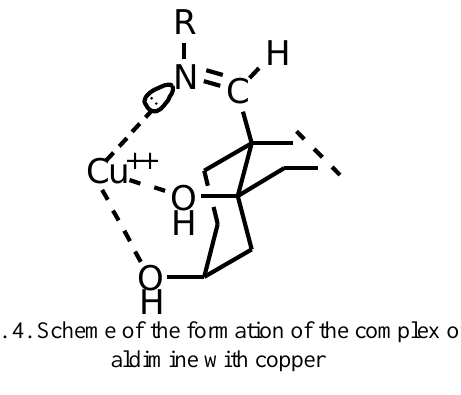
Fig. 4. Scheme of the formation of the complex of aldimine with copper